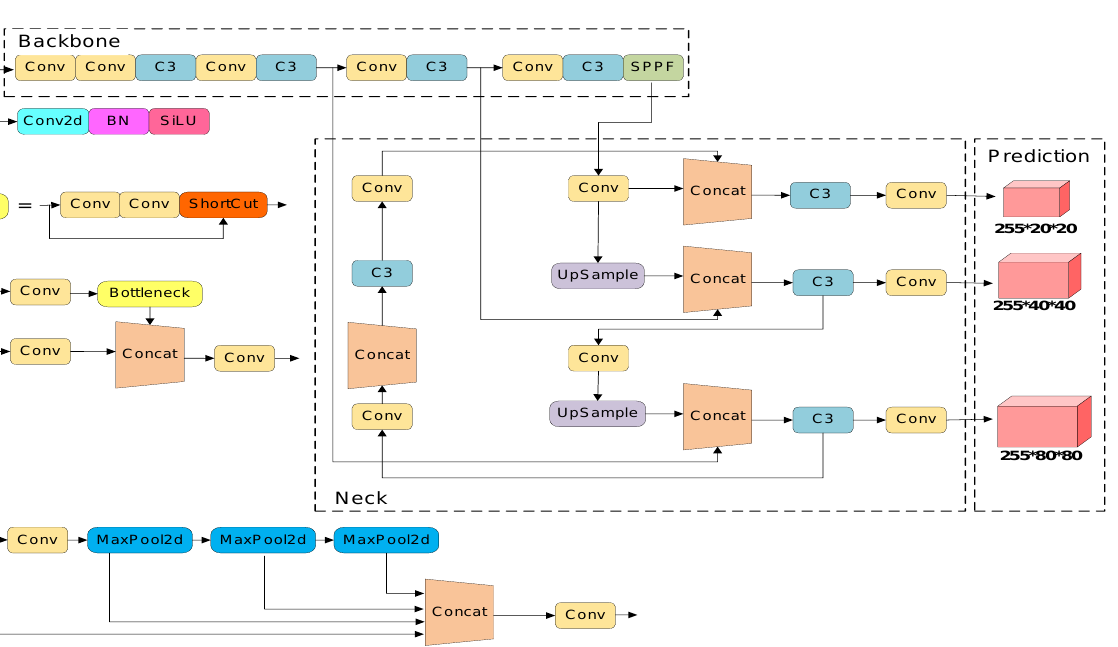
Figure 7. The YOLOv5 structure.